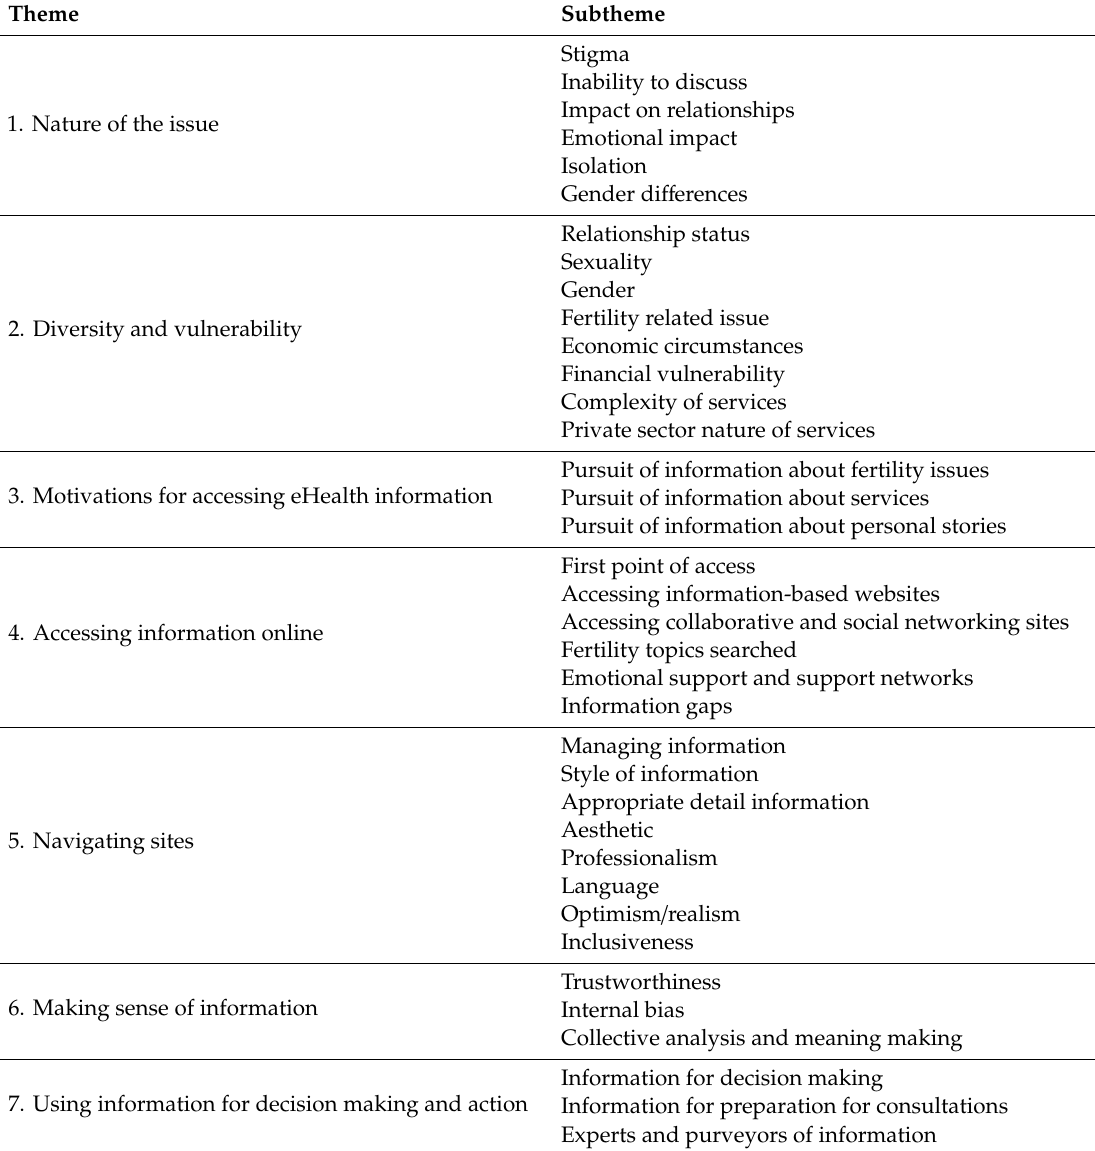
Table 2. Data themes and corresponding